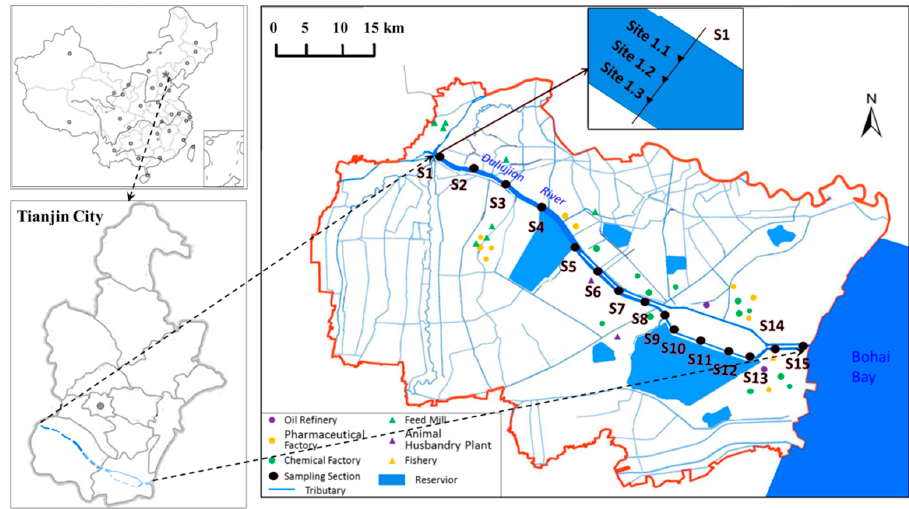
Figure 1. The sampling sections and sites in the study area.